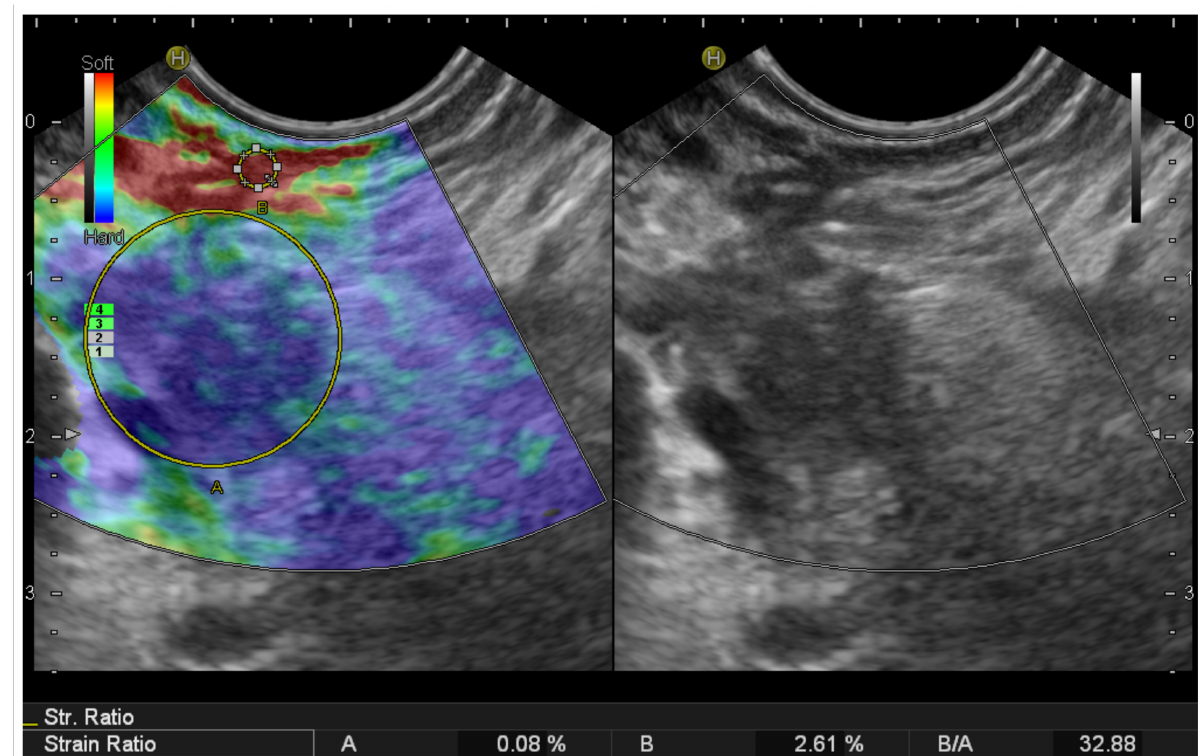
Figure 2. Endoscopic ultrasound elastography of a small pancreatic head neuroendocrine tumor. Two different areas (A, B) from the region of interest were selected for quantitative elastographic analysis. Area (A) is a lesion representative area including the biggest possible area of the tumor. Area (B) refers to soft (red) reference tissue outside the tumor. The quotient (B/A) (strain ratio) is considered as the measure of the elastographic